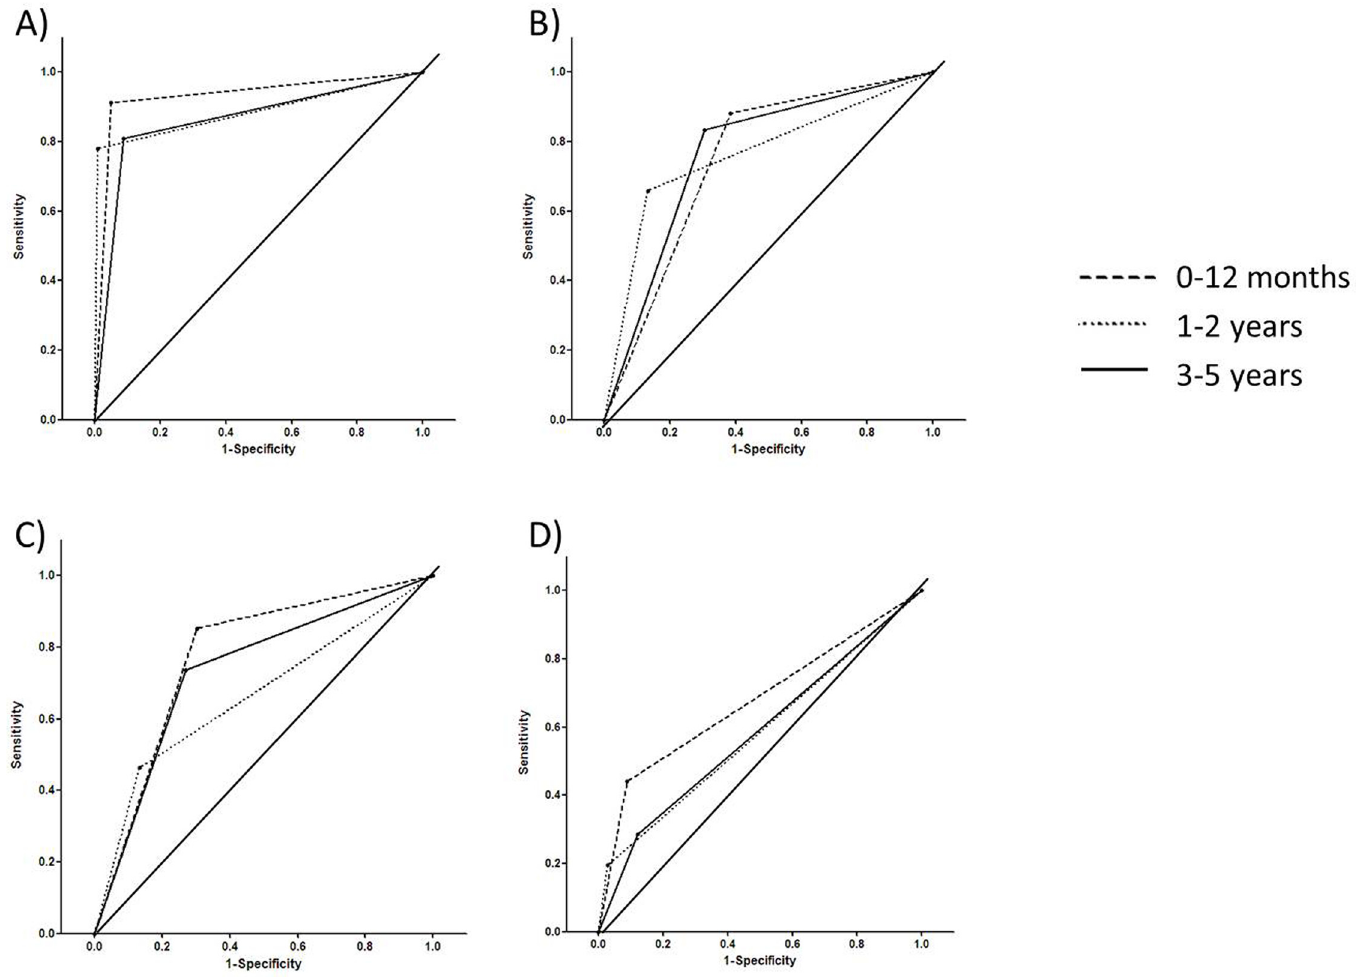
Fig 2. Area under the curve (AUC) for T-SPOT. TB and TST. This figure shows receiver-operating-characteristic (ROC) curves for the sensitivity and specificity of T-SPOT.TB (A) and the TST tests using 5mm, 10mm and 15mm cut-offs (B-D).